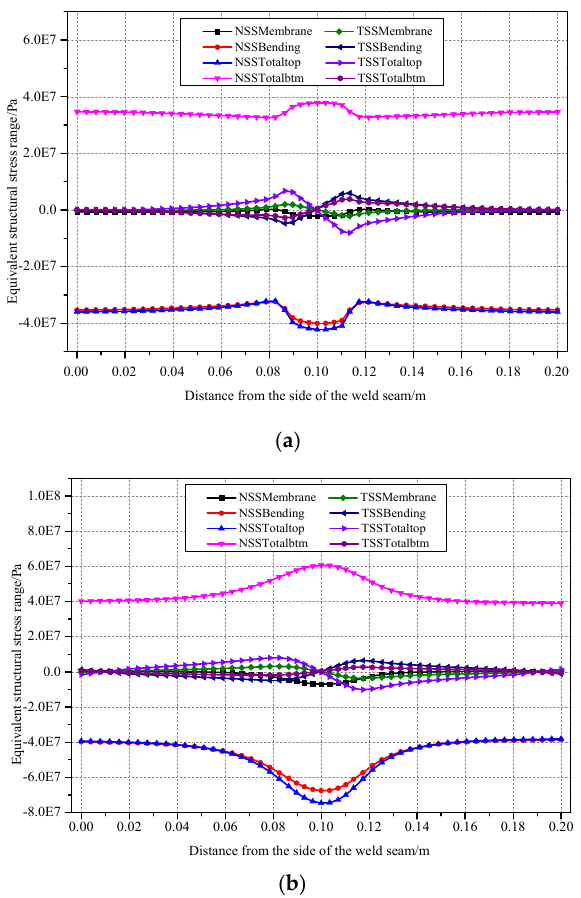
Figure 10. Equivalent structural stress of the weld root and weld toe of a traditional weld seam. ( a ) Equivalent structural stress of Trad-Weldline1, ( b ) equivalent structural stress of Trad-Weldline2. Figure 11 plots the Mises stress and fatigue cyclic life of the bottom side of the bridge deck of the weld seam of a large root. As shown in the figure, the left weld seam (Large-Weldline1) is the weld seam of the large root of the weld toe and bridge deck and the right weld seam (Large-Weldline2) is the weld seam of the large root of the weld root and bridge deck. Compared to the distribution contours of the traditional weld seam (Figure 5), the distribution trend of the Mises stress contours and fatigue cyclic life were similar. Moreover, the location of the maximum stress was the same as in the traditional weld seam.